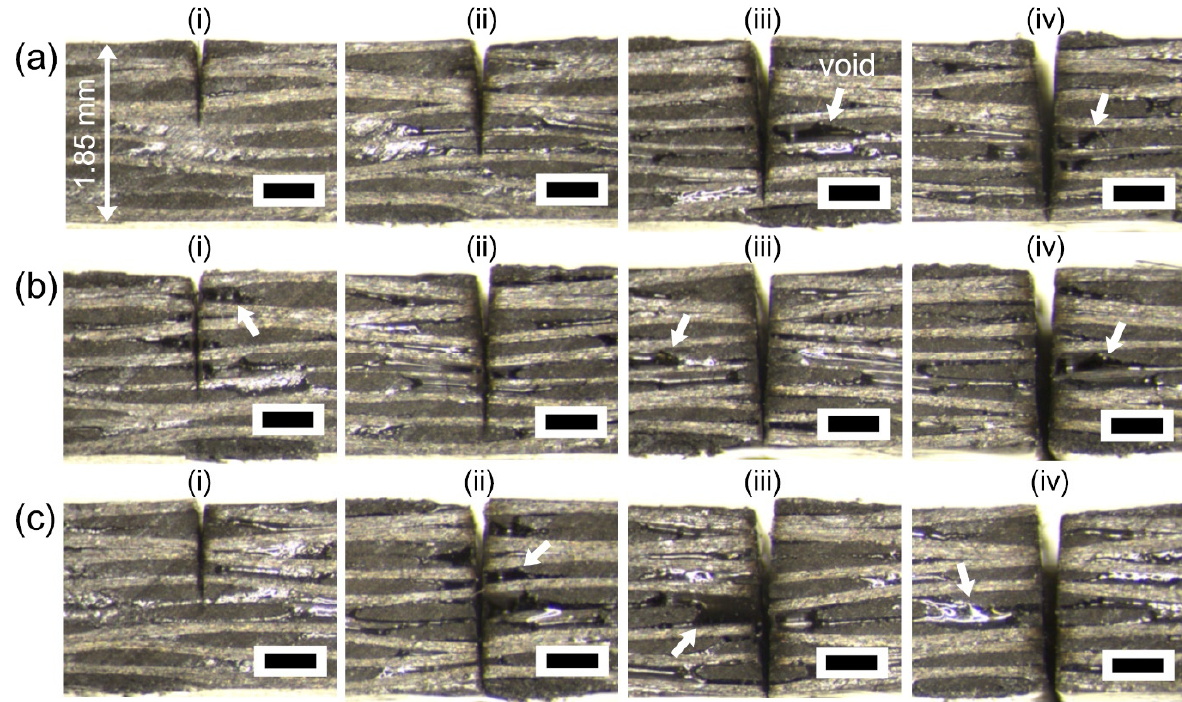
Figure 8. Picosecond laser cutting of the thermoplastic CFRP with lateral multi-pass processing. Stereoscopic microscope cross-section images with ( a ) 50 loops, ( b ) 100 loops, and ( c ) 200 loops, respectively. Each position at (i), (ii), (iii), and (iv) corresponds to multi-pass processing of 5, 10, 15, and 20 passes in lateral direction with 10 µm gap. The common experimental conditions were a power of 16 W and a scan speed of 0.5 m/s. Each scale bar = 500 µm.